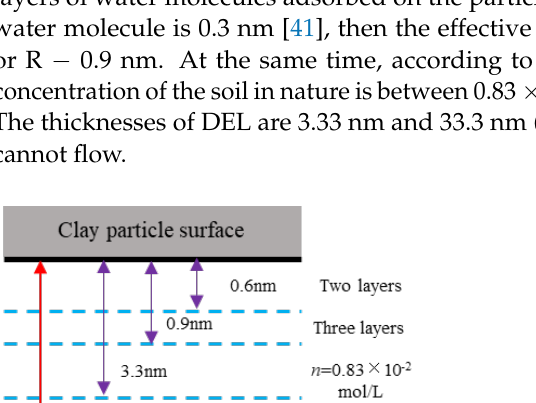
Figure 5. Influence of absorbed water or DEL.